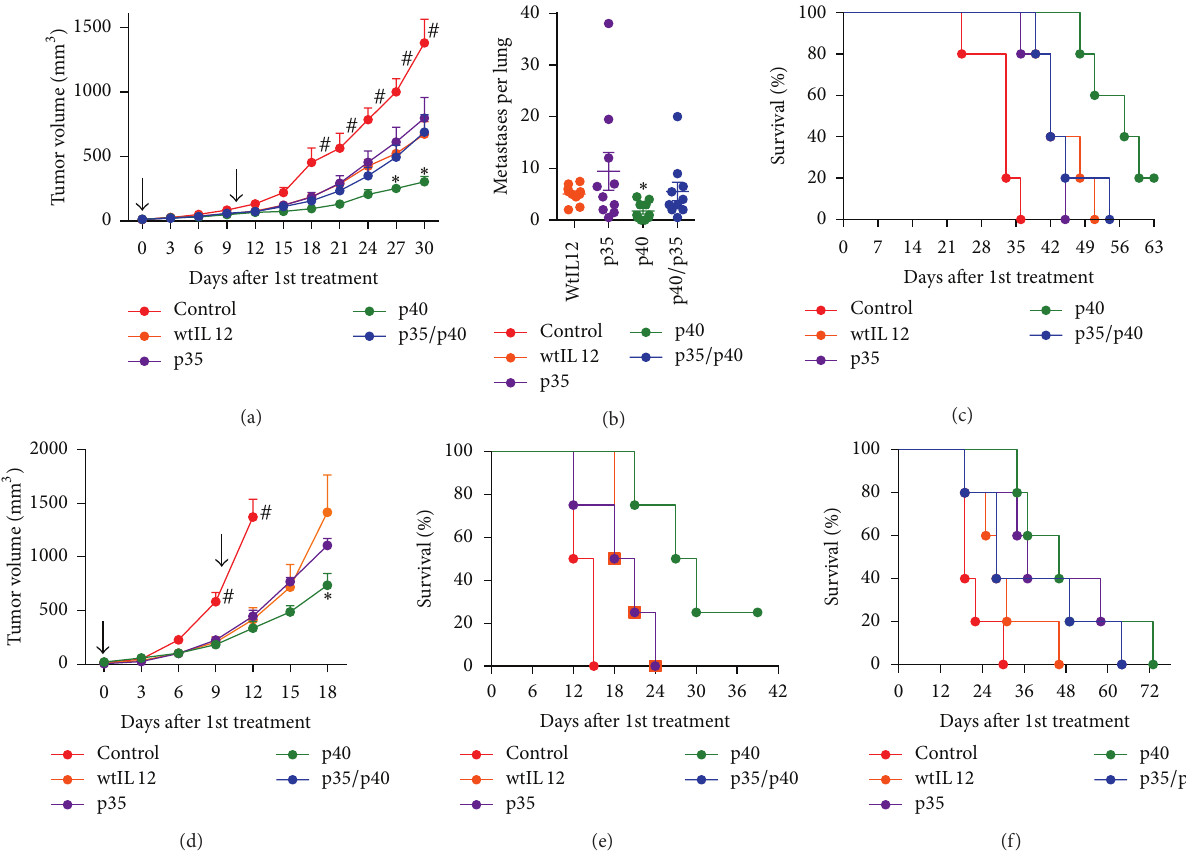
Figure 2: Location of the tumor-targeting sequence affects the induced antitumor response in a tumor histotype-specific manner. The ttIL12- p40 pDNA treatments increased the antitumor activity compared to the wtIL12 pDNA treatments in the 4T1 ((a) primary tumor growth; (b) lung metastases; (c) survival) and B16F10 ((d) primary tumor growth, (e) survival) tumor models. (f) In the SCCVII model, all ttIL12-peptide pDNA treatments significantly extend survival. Black arrows represent treatment dates. # represents 𝑃 < 0.05 compared to all other groups. ∗ represents 𝑃 < 0.05 compared to all other IL12 treatment